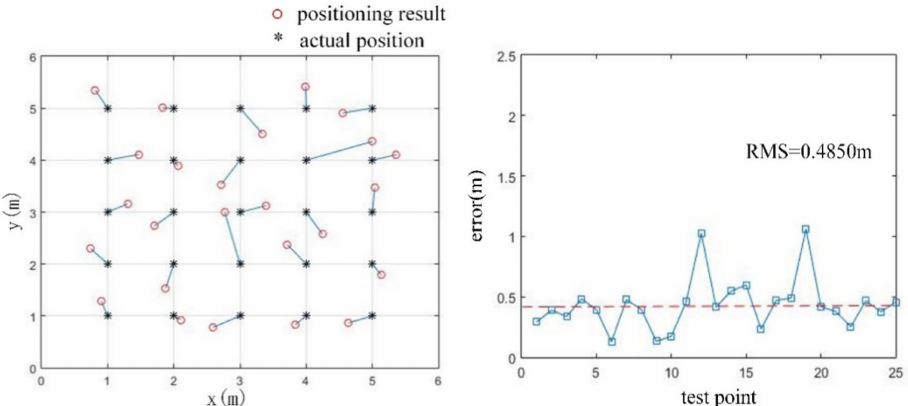
Figure 11. ANN test results with deterministic simulation